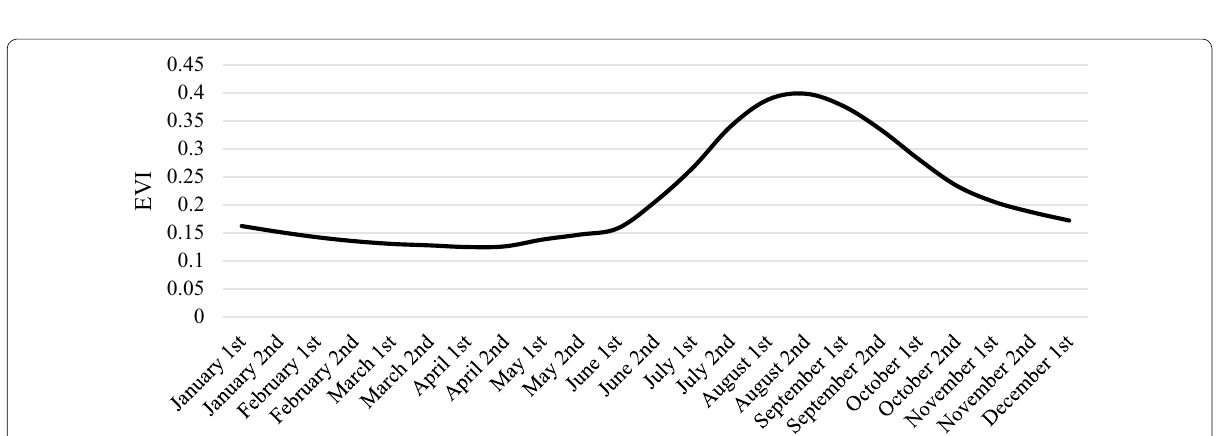
Fig. 3 Annual vegetation greenness pattern in Guna-Tana from bi-monthly EVI